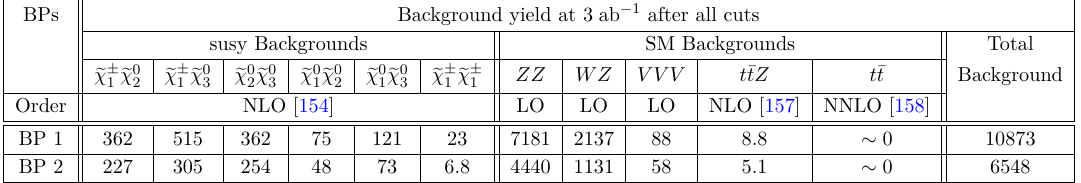
Table 6. The background yield at 14 TeV with 3 ab − 1 of integrated luminosity after the cut-based analysis for the two benchmark points.